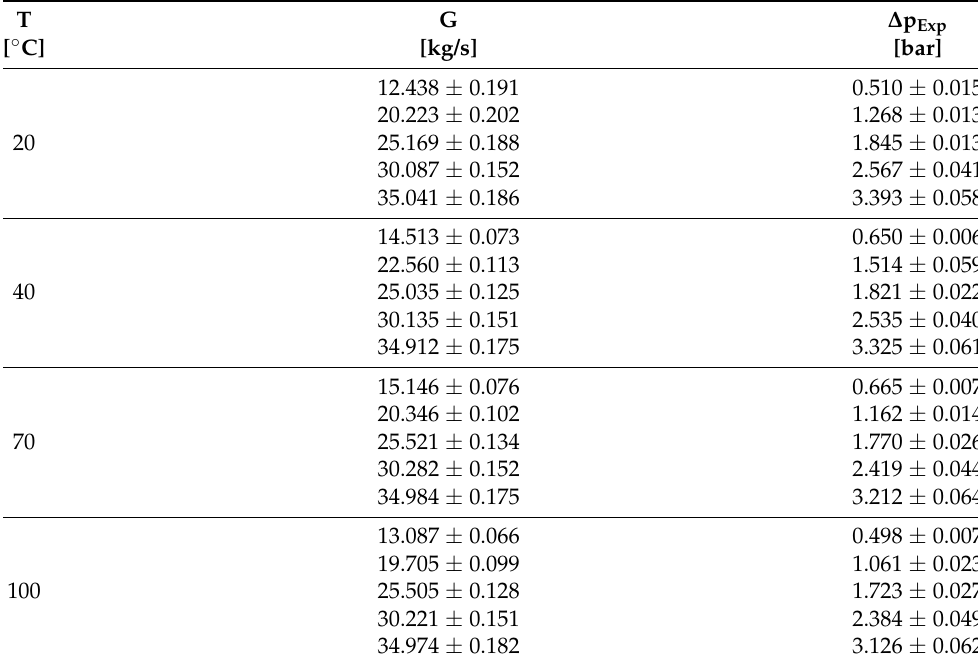
Table 1. Summary of experimental steady-state results.